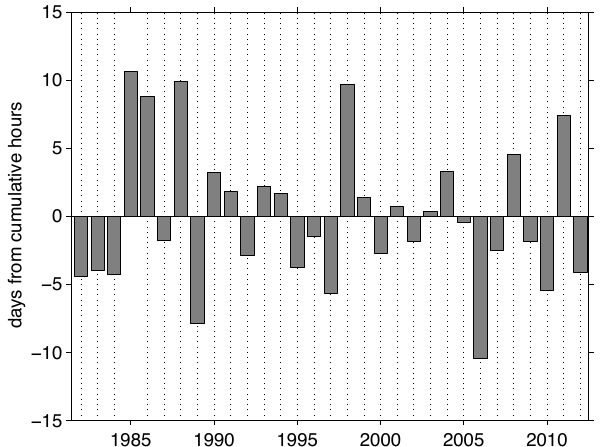
Figure 8. Anomalous days (from cumulative sum of hours) of upwelling favourable winds (see text for definition) per year from summer (June to September) hourly observations recorded at Schönhagen station 1982 to 2012 (compare Fig. 1). Mean is 18.1